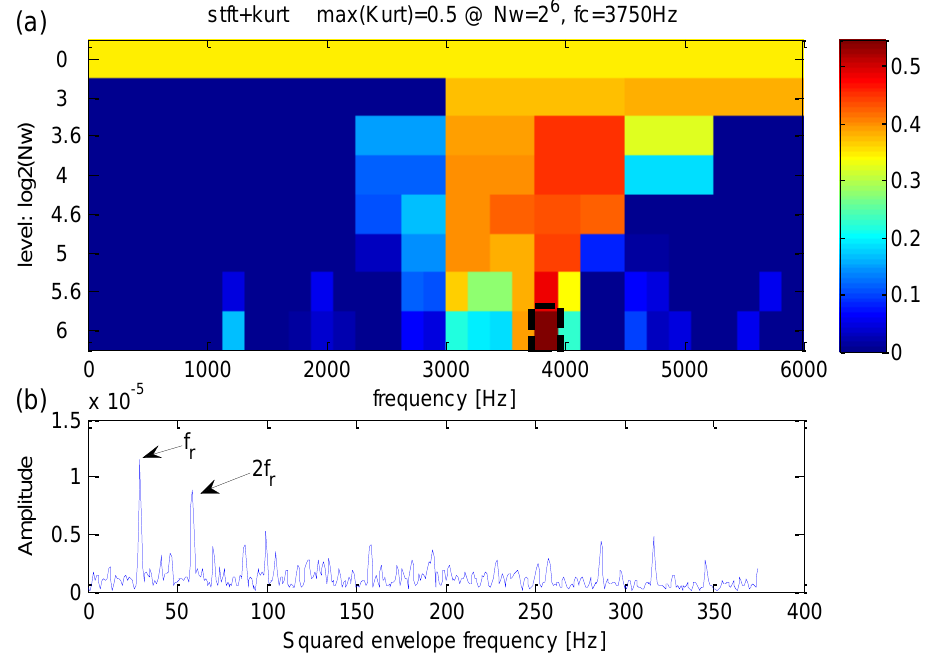
Figure 16. ( a ) The kurtogram of data X224_DE; ( b ) the squared envelope spectrum of the frequency band with the maximum kurtosis.